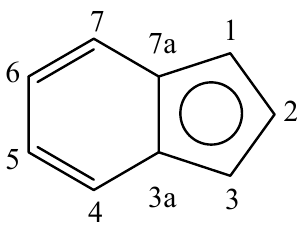
Figure 3. Structure of indenyl